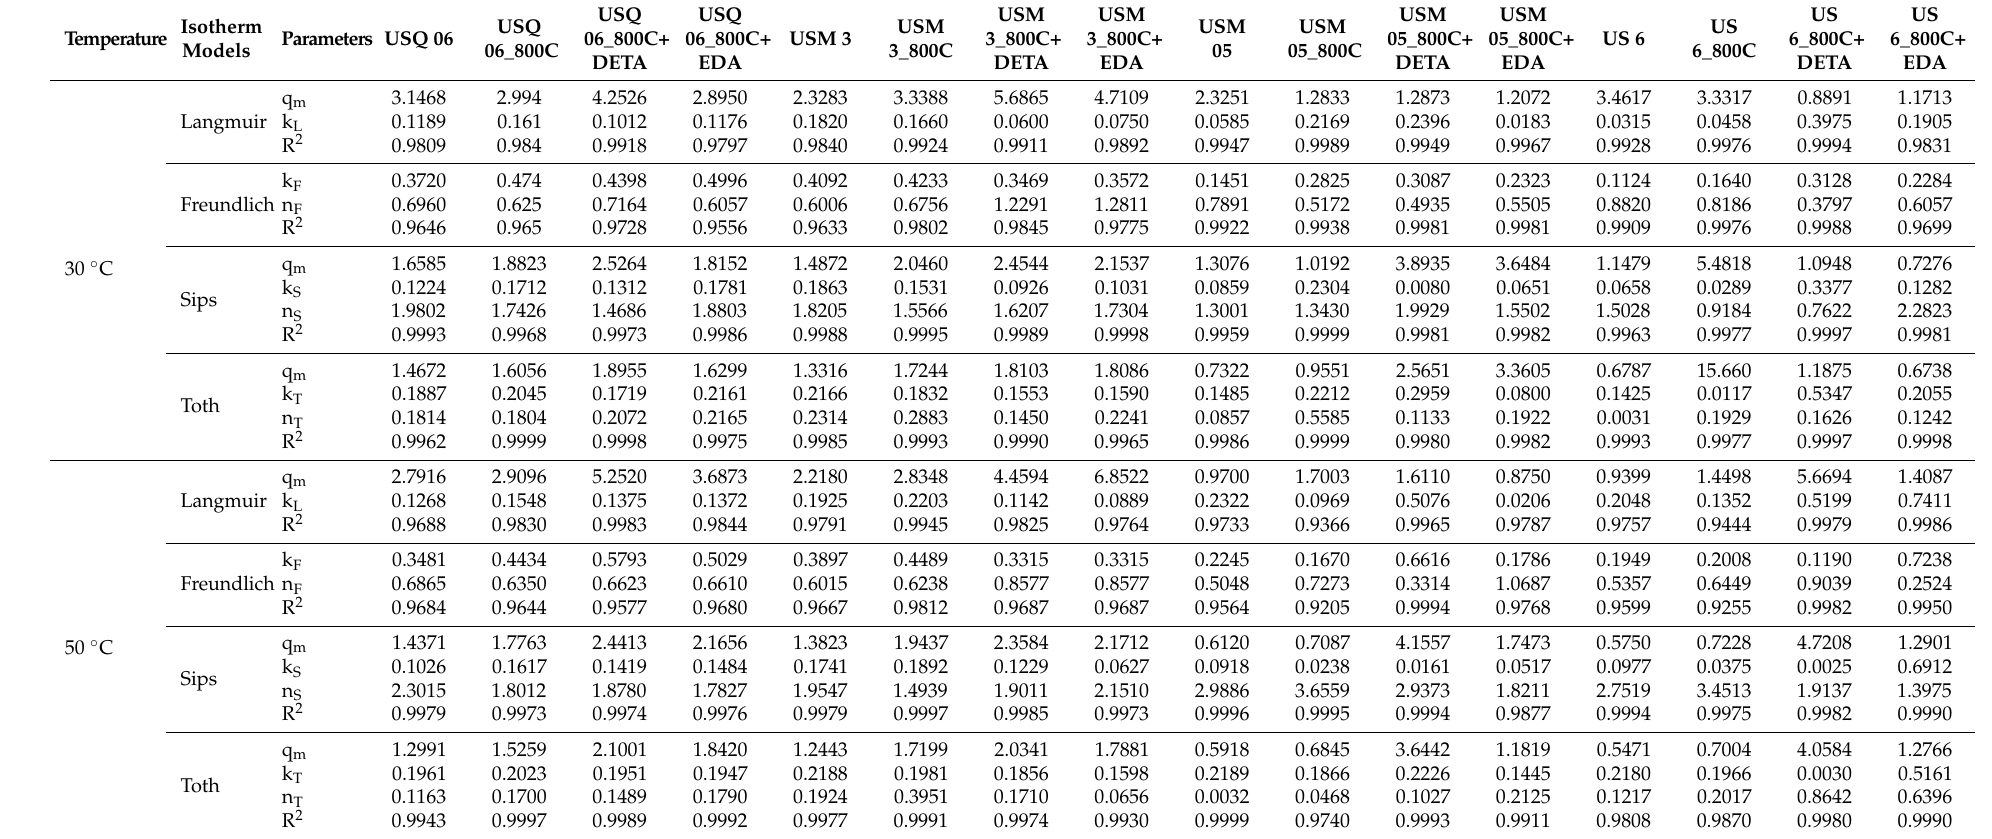
Table 5. The values of isotherm parameters obtained from the curve fit of experimental data at 30 ◦ C, 50 ◦ C, and 70 ◦